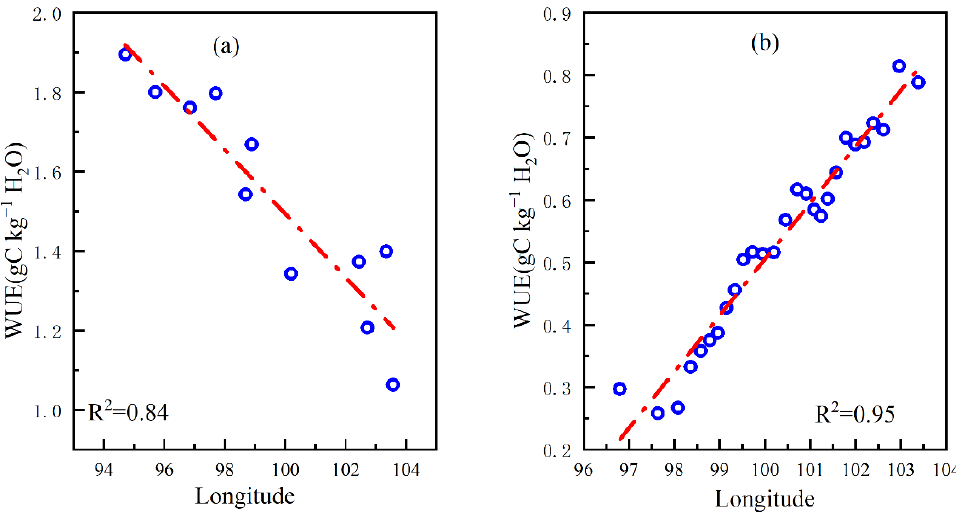
Figure 10. Relationship between longitude and WUE. ( a ) Hexi Corridor Oases, ( b ) Qilian Moun- tains.